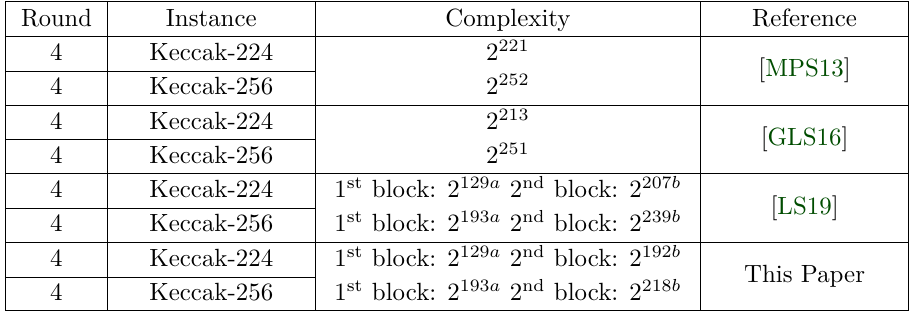
Table 1: Summary of preimage cryptanalysis on 4-round